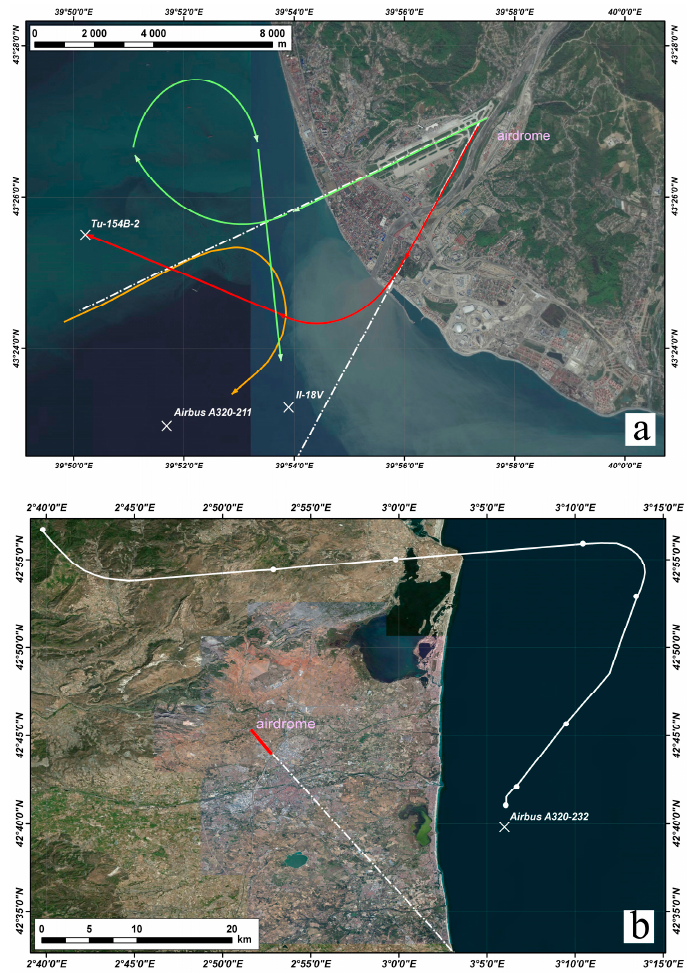
Figure 2. The air routes of Tu-154B-2 (red) and Airbus A320-211 (orange) in Adler/Sochi, Russia ( a ) and of Airbus A320-232 (white) in Perpignan, France ( b ). The glide paths from the aircraft’s position over the sea are marked by the dashed white lines. The air route of Il-18V (green) crashed near Adler/Sochi, Russia ( a ) on 01.10.1972 at 16:25 UTC, is shown in addition.